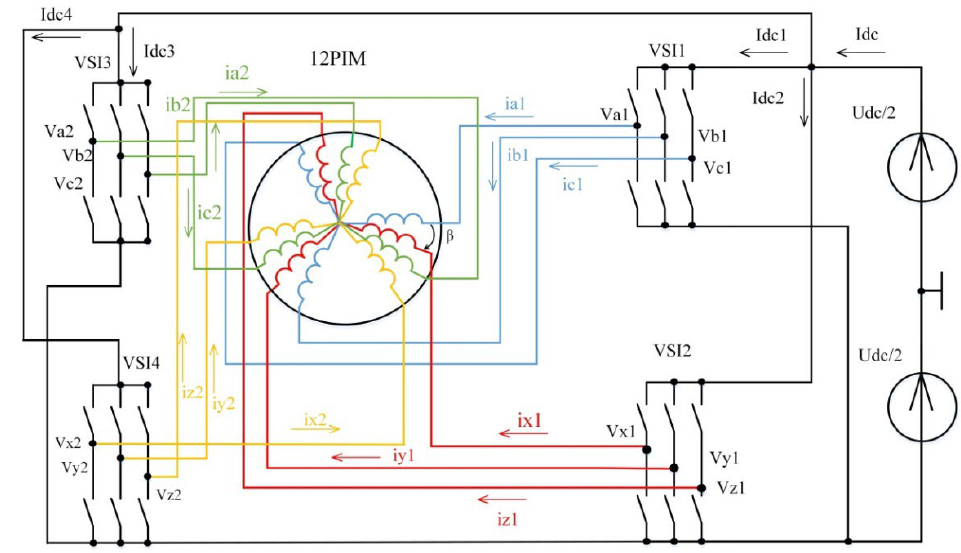
Figure 5. Block diagram of switch control-based four-winding IM.